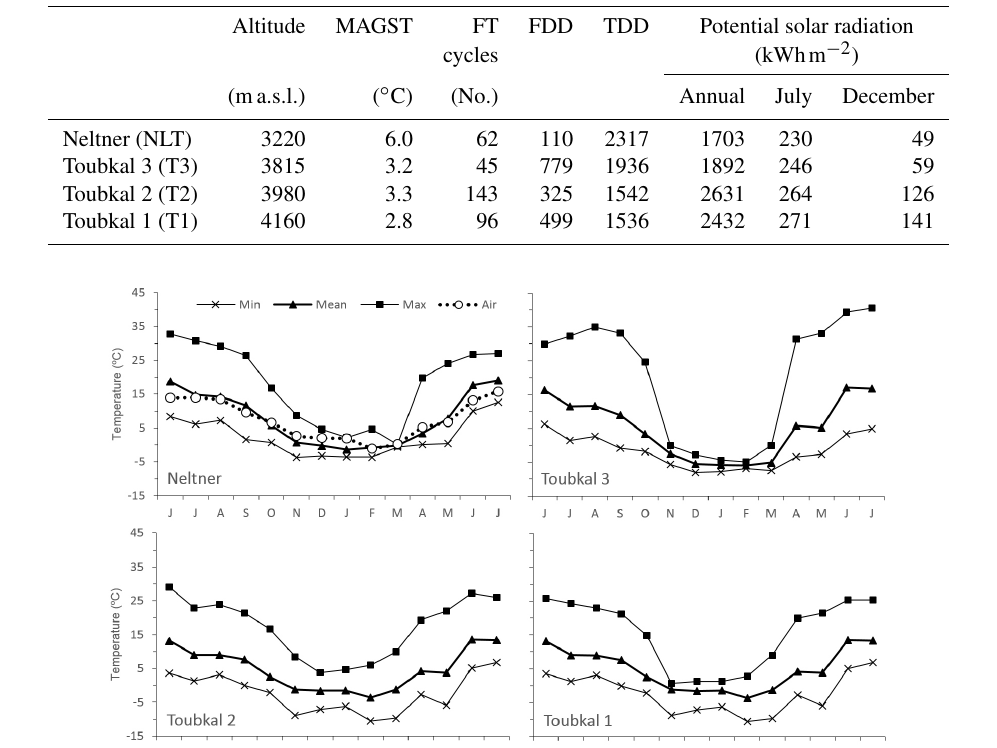
Table 2. Ground temperatures, frost indices and modelled potential solar radiation in the monitoring sites of the Toubkal massif.